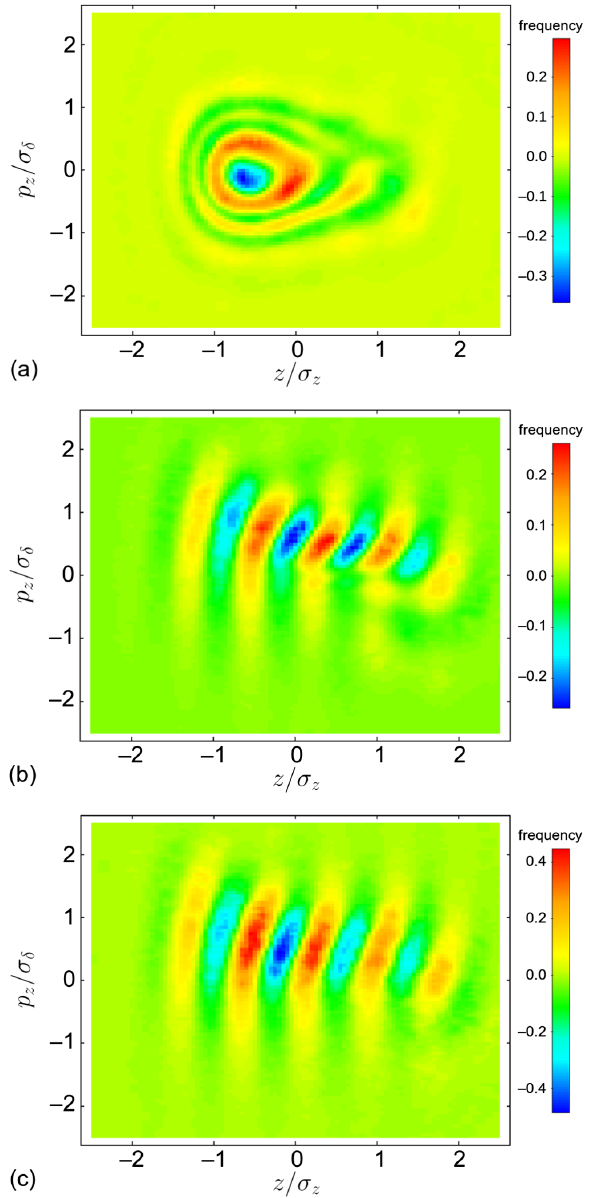
FIG. 8. Unstable longitudinal phase space density perturbations extracted from ELEGANT simulations for the quartic potential and 8 . Panel (a) has no synchrotron emission and shows that k ξ σ z ¼ while the instability is dominated by the m ¼ 0 mode it has ˆ λ complicated radial dependence when ℑ ð Þ ¼ 5 and chromaticity plays an important role to control the instability. When the ˆ λ strength increases to ¼ 7 > 3 k ξ σ z = 4 we get the results in panel (b), for which the perturbation becomes more aligned with the p z axis. Panel (c) is for the same parameters as panel (b) but also includes synchrotron emission.